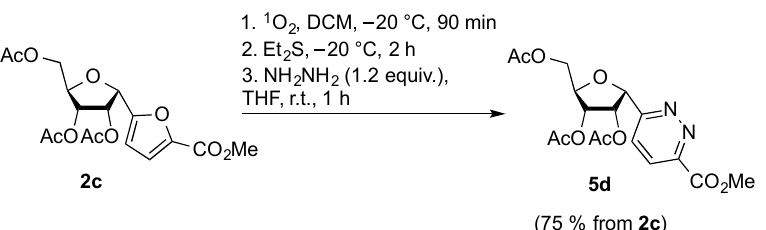
Scheme 7. One-pot synthesis of the 3-(2 ′ ,3 ′ ,5 ′ -tri- O -acetyl- α - D -ribofuranosyl)-6-(methoxycarbonyl)pyridazine ( 5d ).